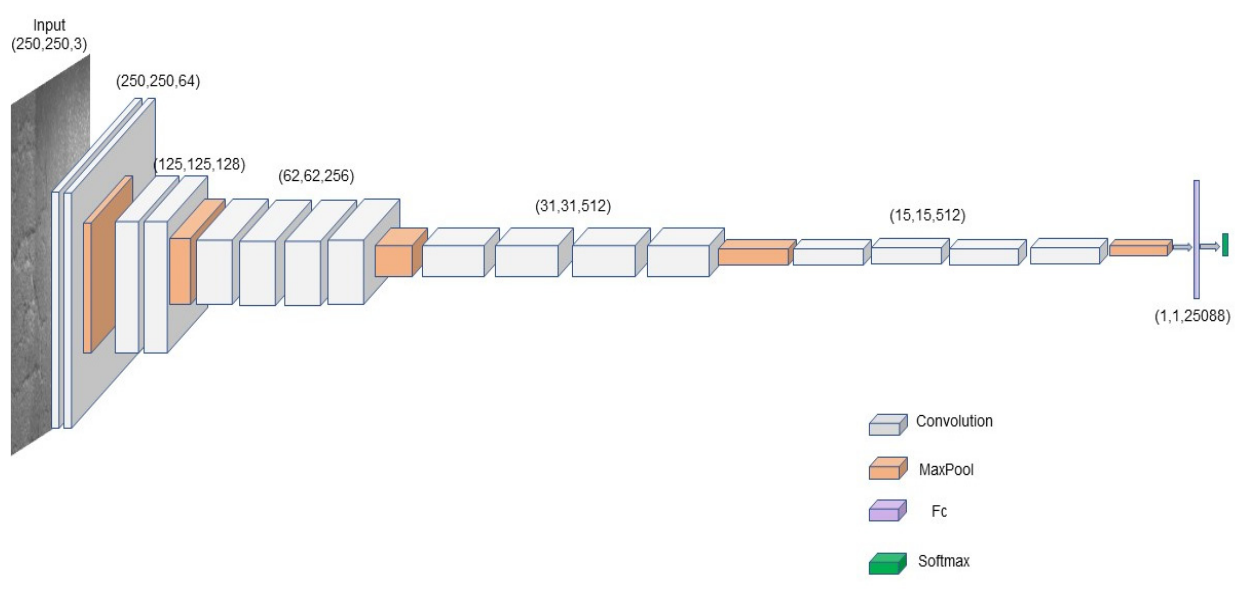
Figure 4. Schematics of VGG-19 deep learning model architecture.